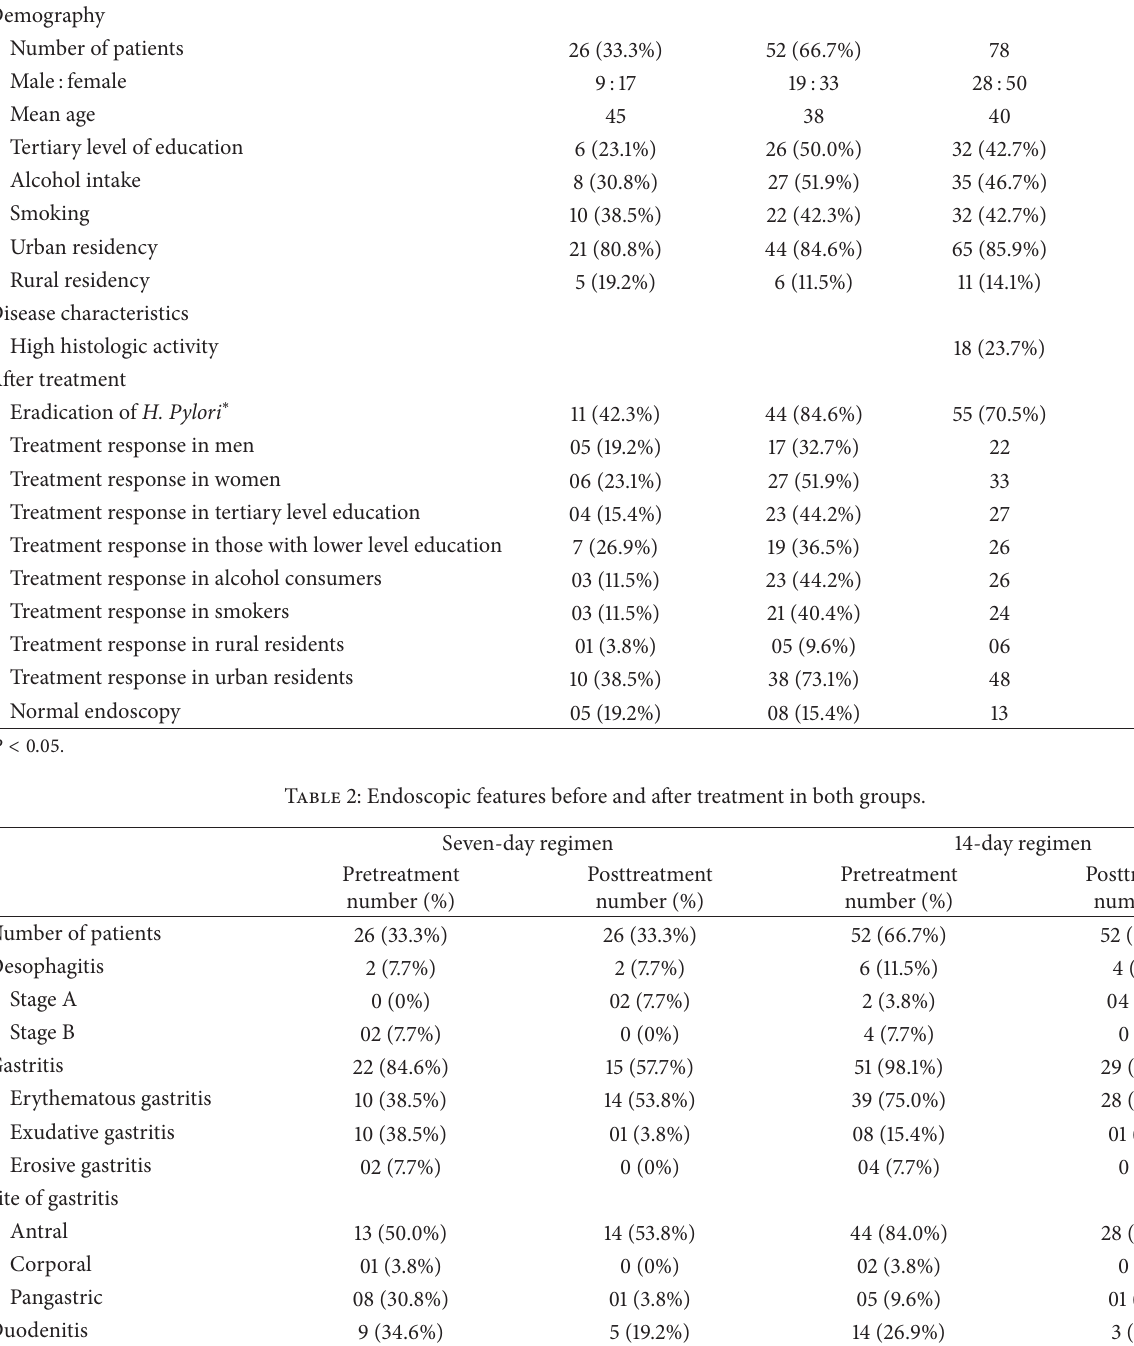
Characteristics